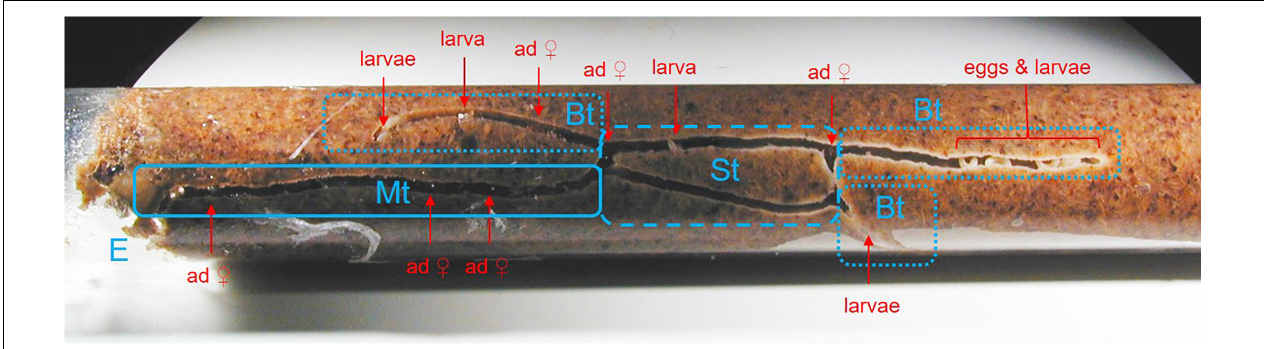
FIGURE 1 | Morphology of a X. affinis laboratory gallery in artificial medium at about 60 days after its foundation. Note the species-characteristic tunnel system with the four compartments: E, entrance; Mt, main tunnel; St, side tunnel; Bt, brood tunnel. A white fungal layer and white larvae are visible within the Sts and the Bts. Several adult beetles are sitting in the Mt and a few in the Sts and the Bts.